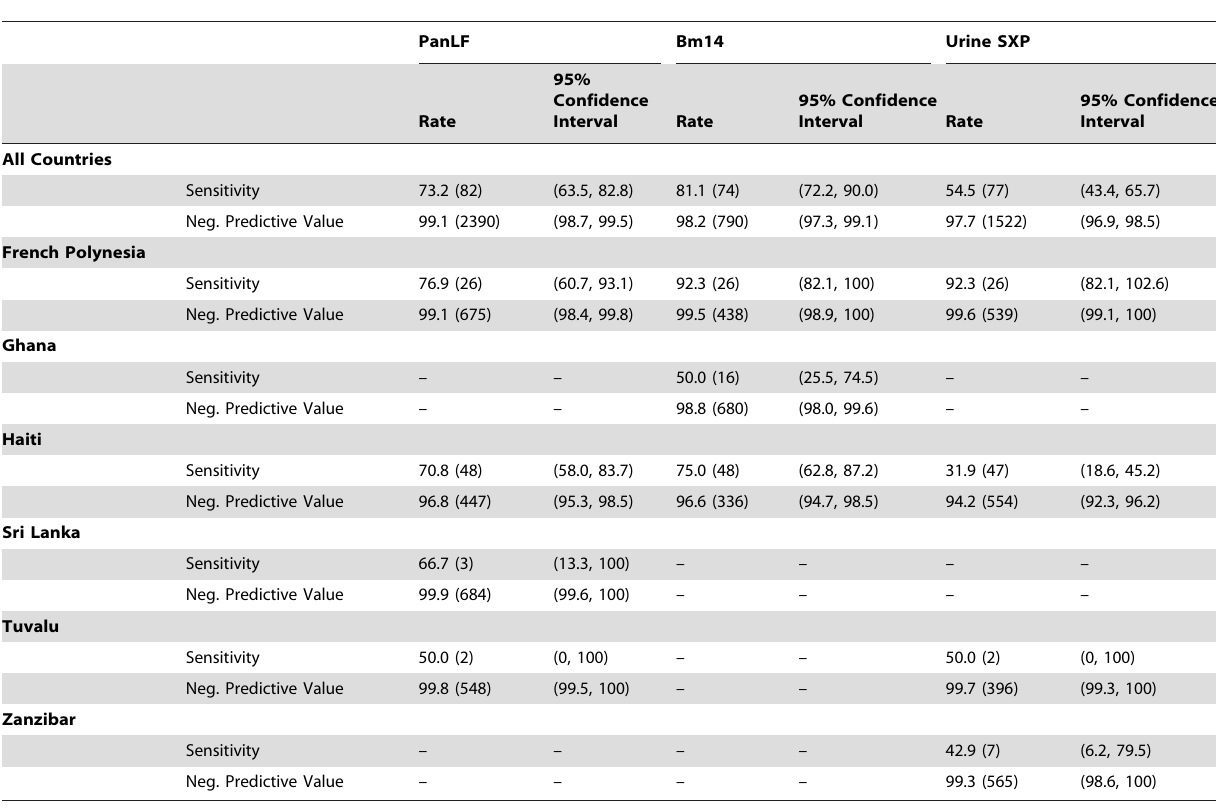
Table 14. Sensitivity, specificity, and predictive values for antibody